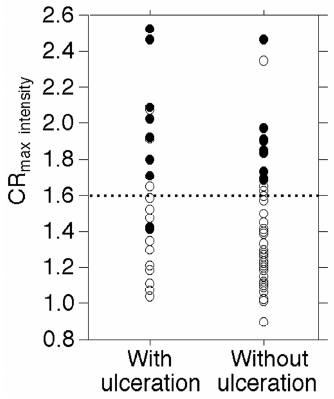
Figure 3. Relationship among ulceration of stenotic lesions, CR max intensity , and development of MES during exposure of the carotid arteries. Closed and open circles indicate patients with and without MES, respectively. Dashed horizontal line denotes CR max intensity of 1.60.